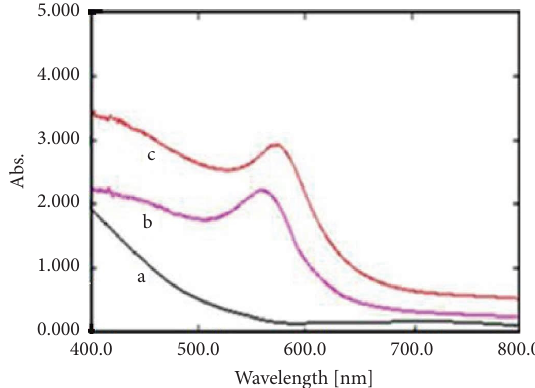
Figure 2: UV-Vis spectra of (a) Cu 2+ , (b) colloidal CuNPs/DA1, and (c)